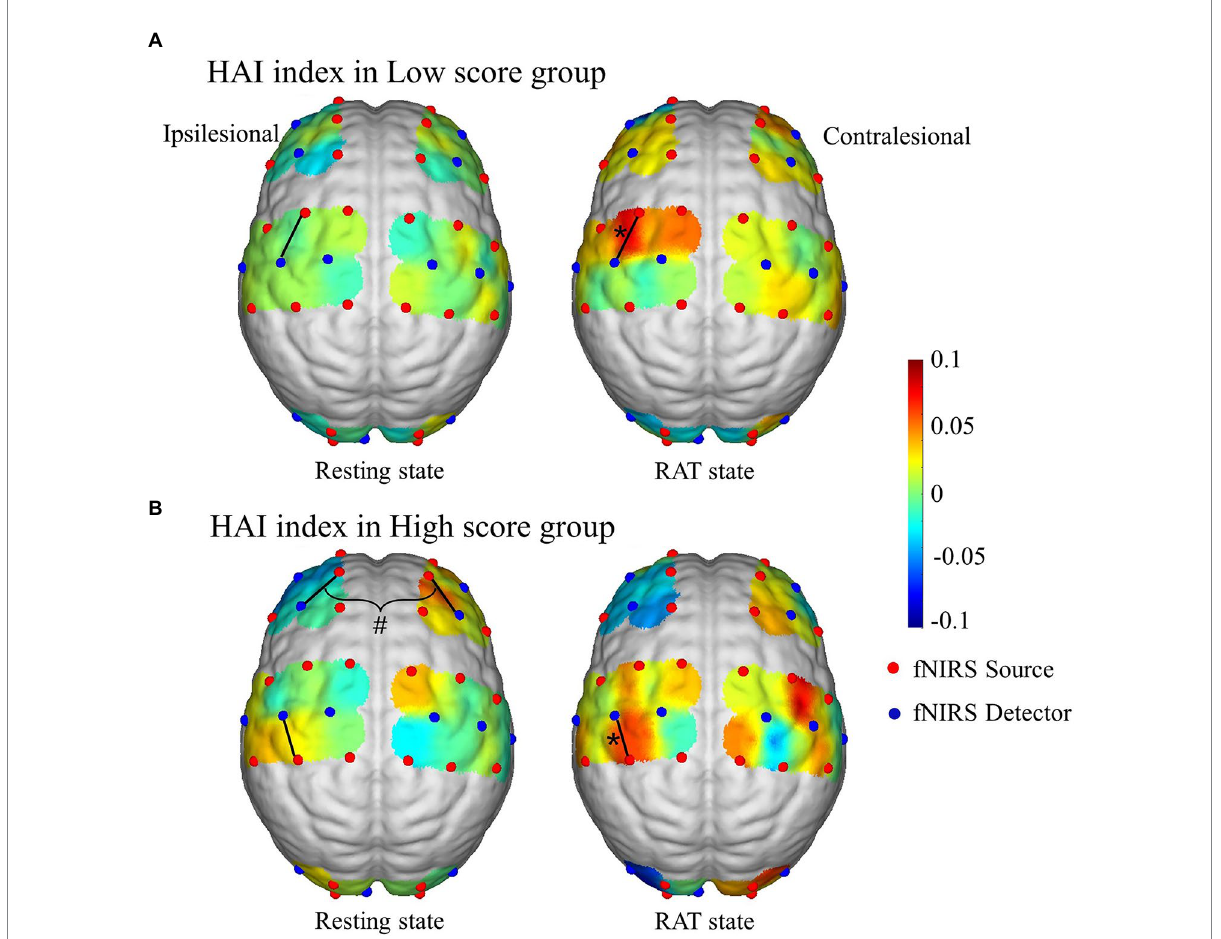
FIGURE 5 Connection-based HAI values in the resting state and RAT state in the high score group (A) and low score group (B) . *Denotes that the within- group difference is statistically significant; # denotes that the difference between hemispheres is statistically